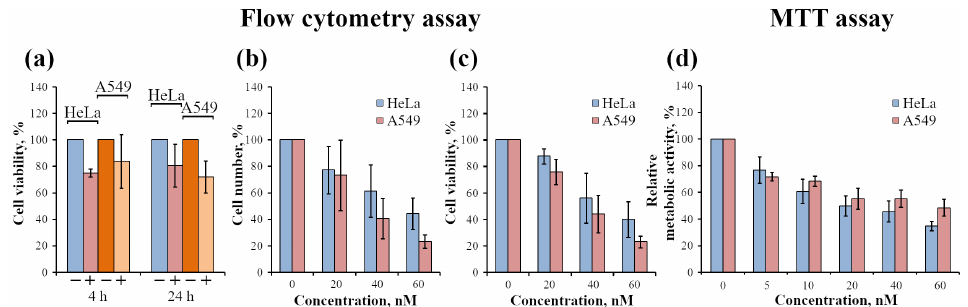
Figure 8. Analysis of the cytotoxic effect of InP-QDs on HeLa and A549 cells by flow cytometry ( a – c ) and MTT ( d ) assays. ( a ): Viability (PI test) of control HeLa and A549 cells (–) and after incubation with InP-QDs (20 nM) for 4 and 24 h (+). The proportion of live cells in the control (–) was considered to be 100%. ( b ): Total number of HeLa and A549 cells after incubation of cells with InP-QDs at various concentrations for 24 h (in %). The total number of cells in the control group was considered to be 100%. The changes in the number of cells were estimated separately as a percentage for each line in relation to the corresponding control. ( c ): Viability (PI test) of HeLa and A549 cells during incubation of cells with InP-QDs at various concentrations for 24 h (in % of corresponding control). ( d ): MTT analysis of the metabolic activity of HeLa and A549 cells after 24 h of incubation with InP-QDs. The optical density of formazan produced by the metabolic active control cells not incubated with InP-QDs was taken to be